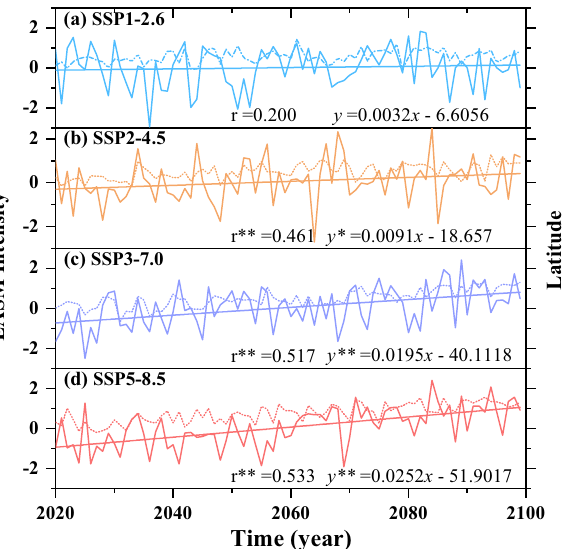
Figure 4. Timeseries of EASM intensity (polylines) and meridional migration of the EASM northern boundary (dotted lines) projected by CMIP6 MME during the twenty-first century. Plotted projections by CMIP6 MME for SSP1-2.6 ( a , cyan), SSP2-4.5 ( b , orange), SSP3-7.0 ( c , medium purple), and SSP5-8.5 ( d , red) compared to the present day. The solid lines indicate the linear fit. r is the correlation coefficient between EASM intensity and meridional migration of the EASM northern boundary. The asterisk indicates a 5% of significance level and the double asterisk indicate a 1% of significance